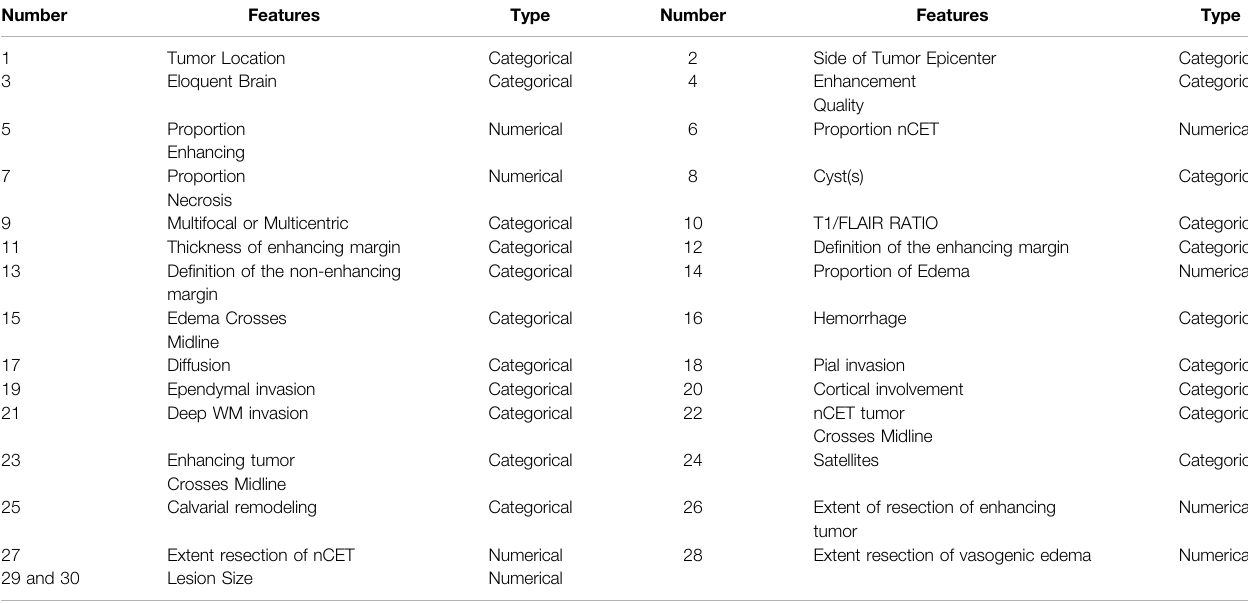
TABLE 1 | Data features extracted from brain tumors MRI.